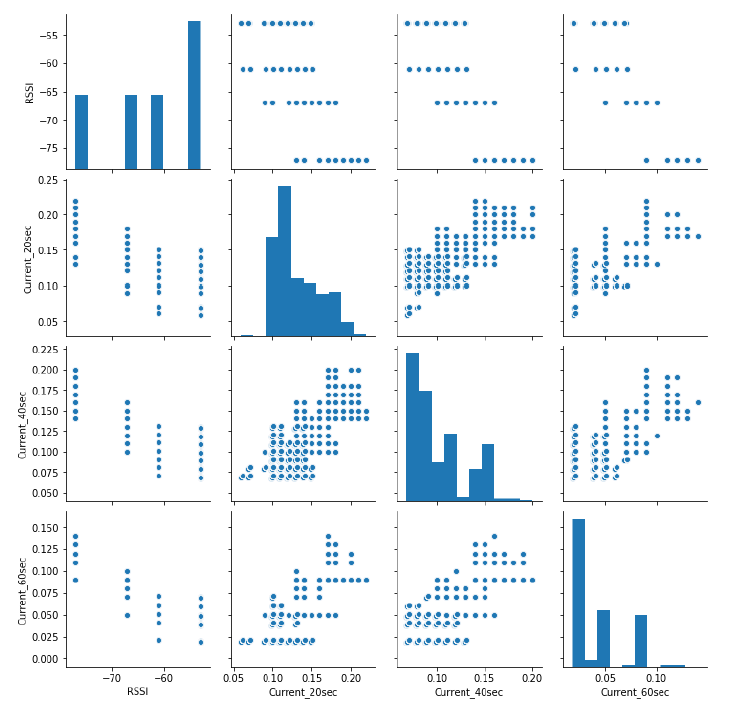
Figure 11. Pair plot of the used